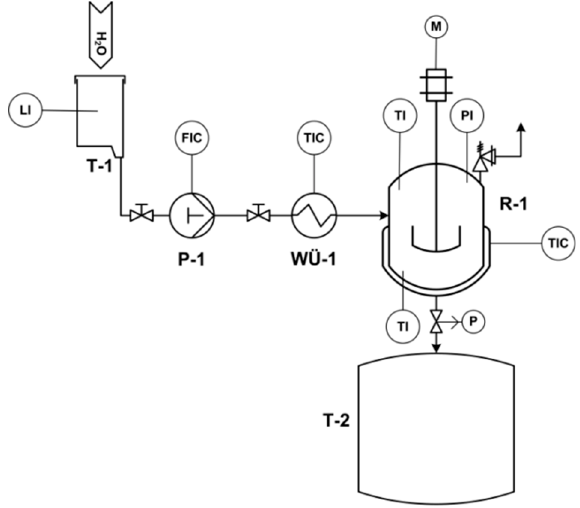
Figure 1. P&ID of the steam explosion miniplant. T-1: deionized water tank, P-1: HPLC pump, WÜ-1: electrical preheater for steam generation, R-1: steam explosion reactor with surrounding heating tape and insulation, and T-2: flash tank.